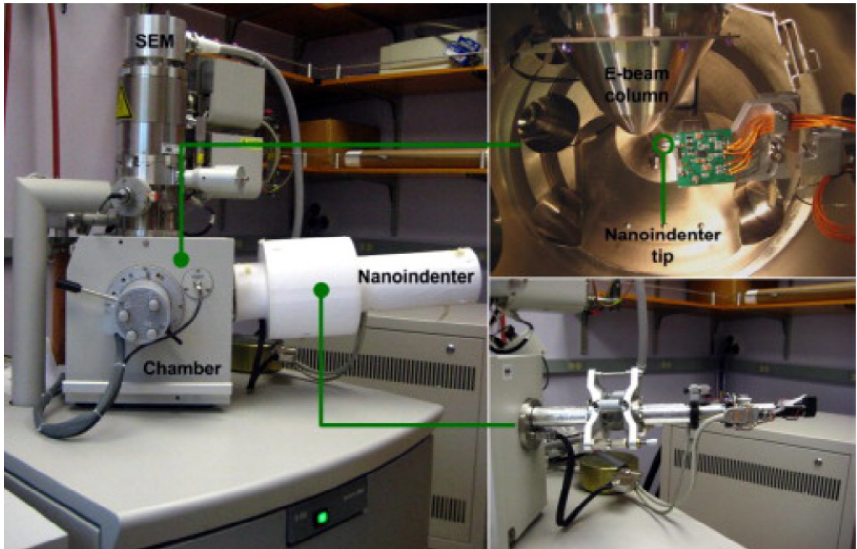
Fig. 1. Pictures of the SEMentor (SEM + Nano-indenter) and the inside of chamber. Reprinted with permis- sion from Kim JY, Greer JR. 2009. Tensile and compressive behavior of gold and molybdenum single crystals at the nano-scale, Acta Materialia 57 (94), (c) 2009 Elsevier